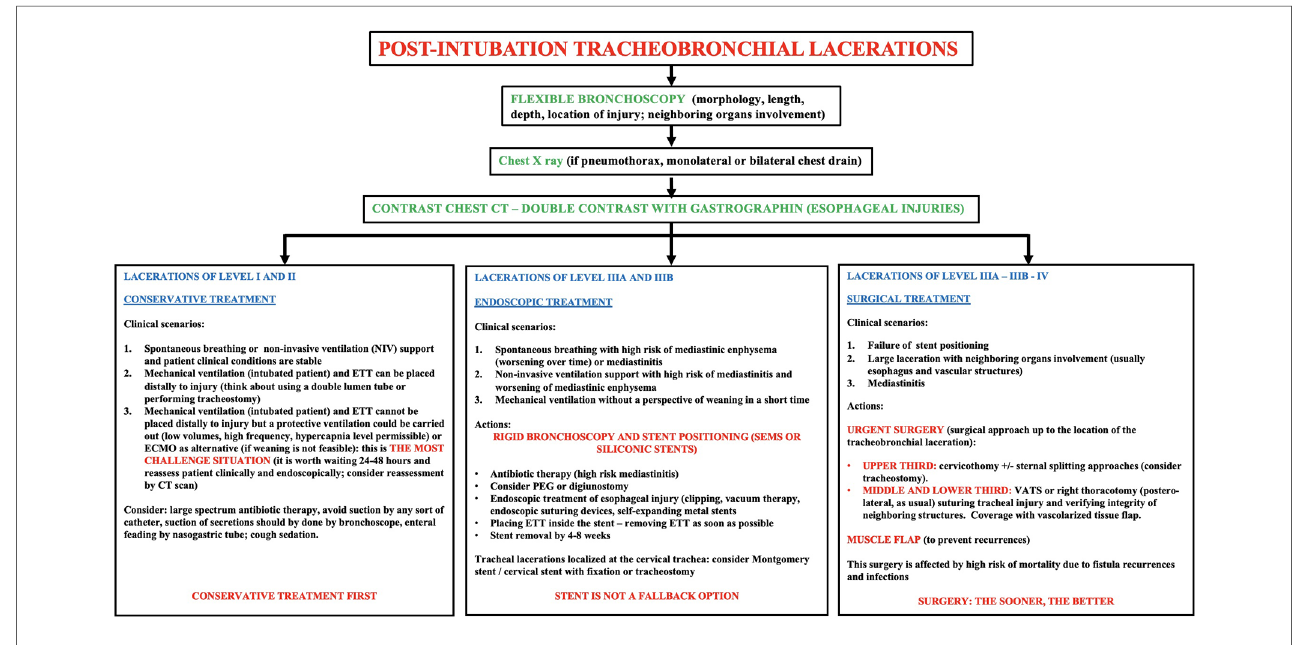
FIGURE 1 Diagnostic-therapeutic algorithm proposal for management of post-intubation tracheobronchial